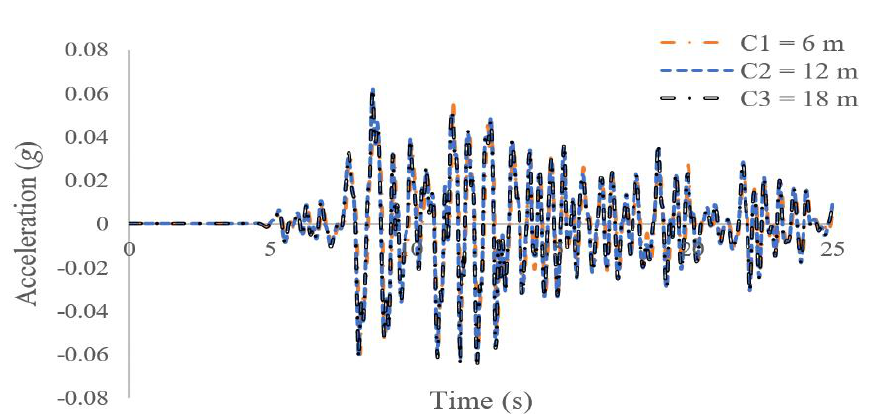
= 𝟏 , 𝑪 𝟐 = 𝟐 , and 𝑪 𝟑 = 𝟑 . 𝑫 𝑫 𝑫